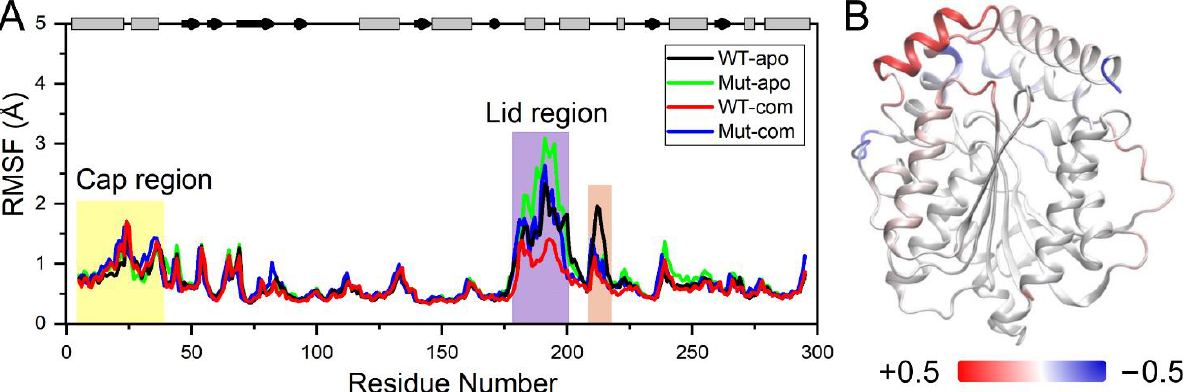
Figure 3. System stability of all systems. ( A ) C α RMSFs based on the last 100-ns MD trajectories for each system used their average conformations as references. The results of all systems are averaged over the three replicate simulations. ( B ) Changes in RMSF upon mutations displayed on the apo structure according to a color scale (lower and higher flexibilities depicted in blue and red,